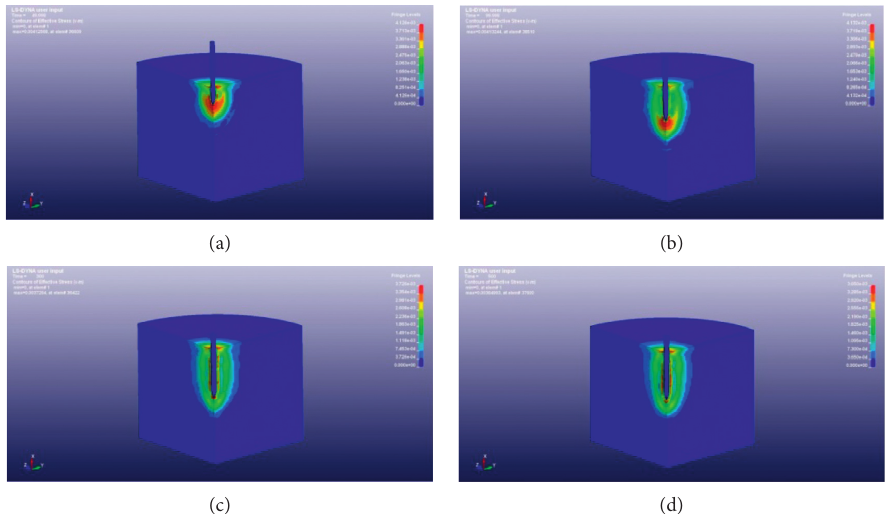
Figure 11: Stress nephograms of a projectile penetrating into a thick, finite-radius, metallic target at different times, (a) t � 0 . 05 ms, (b) t � 0 . 1ms, (c) t � 0 . 3ms, and (d) t � 0 . 5ms.